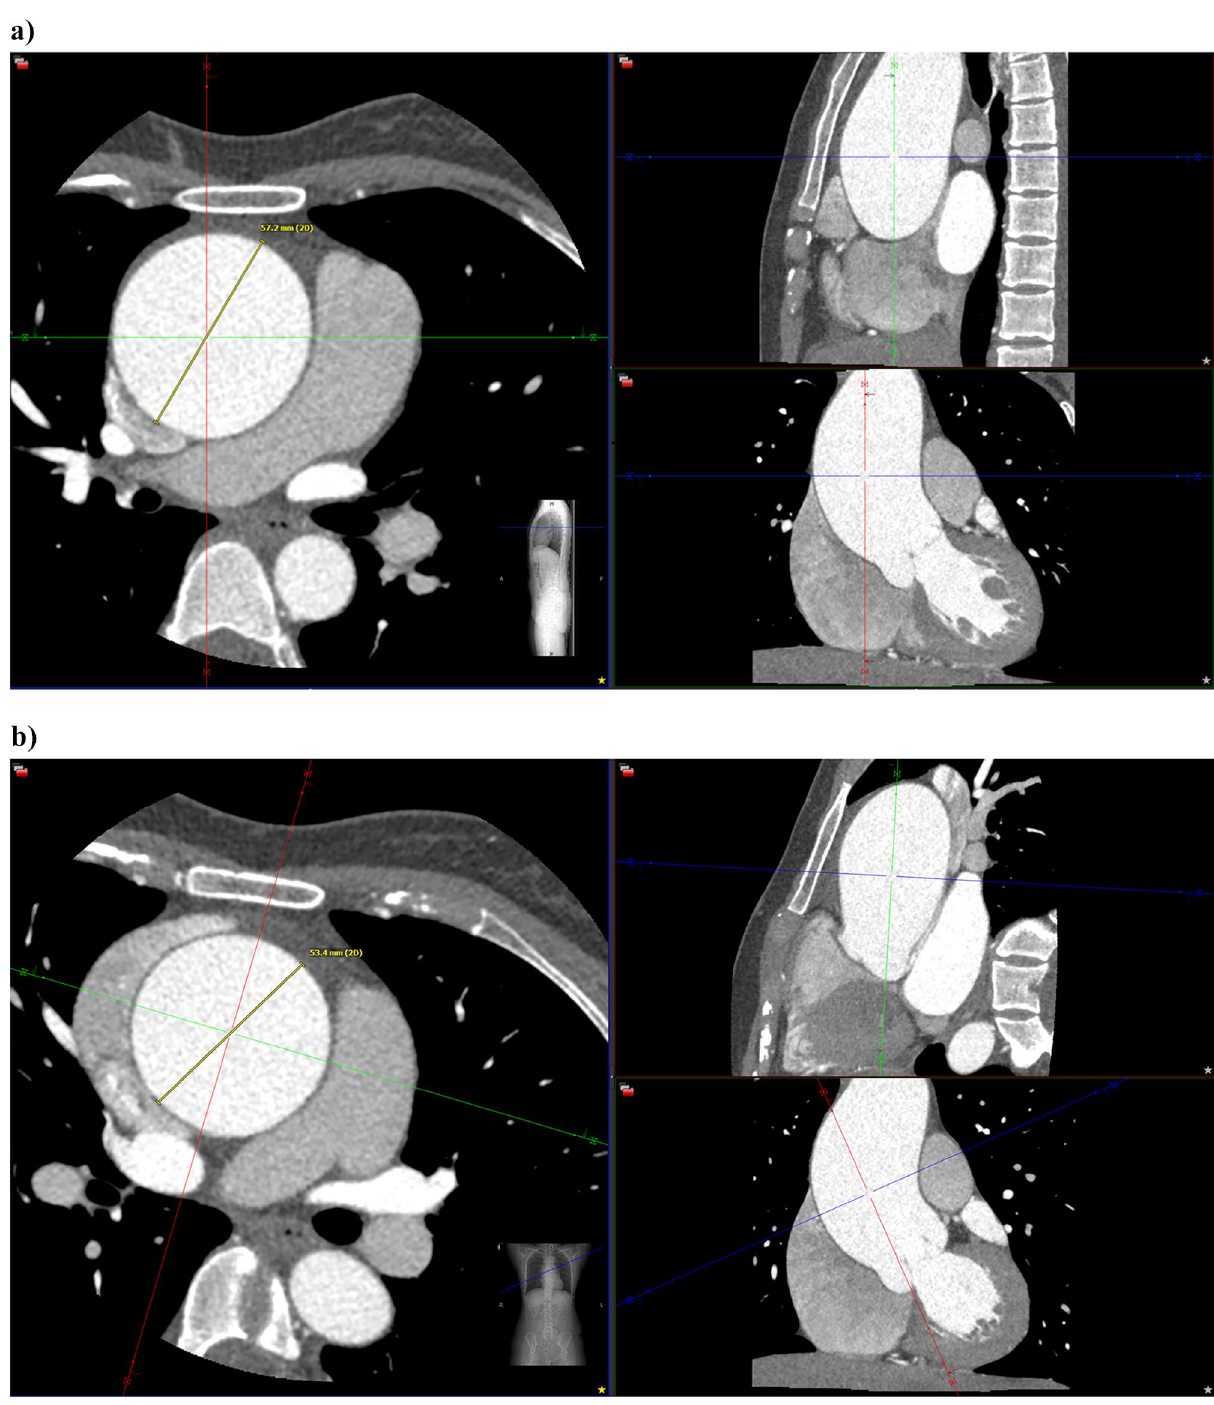
Figure 1. Example illustrating the importance of double oblique multiplanar reconstruction perpendicular to the course of the vessel for correct aortic diameter measurement: ( a ) from unreconstructed CT, a wrong ascending aortic diameter of 57.2 mm is measured; ( b ) measurement from reconstructed CT yields the correct aortic diameter of 53.4 mm. Like TTE, unreconstructed CT may preclude correct diameter measurement perpendicular to the course of the vessel in patients with an elongated aorta and/or thoracic deformities. CT = computed tomography; TTE = transthoracic